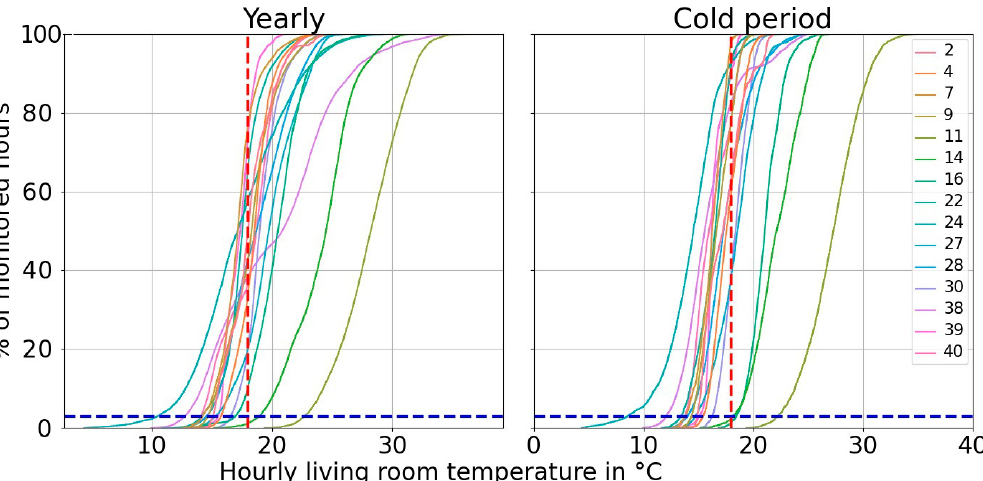
Figure 7. Hourly living room temperatures for the length of the study (left) and those in the cold season (right). The cold season comprises the period from 1 October to 28 February. The dashed horizontal blue line shows the limit of hours (3%) that the homes must not exceed before meeting the dashed red vertical line, which represents the 18 °C temperature threshold recommended by WHO.